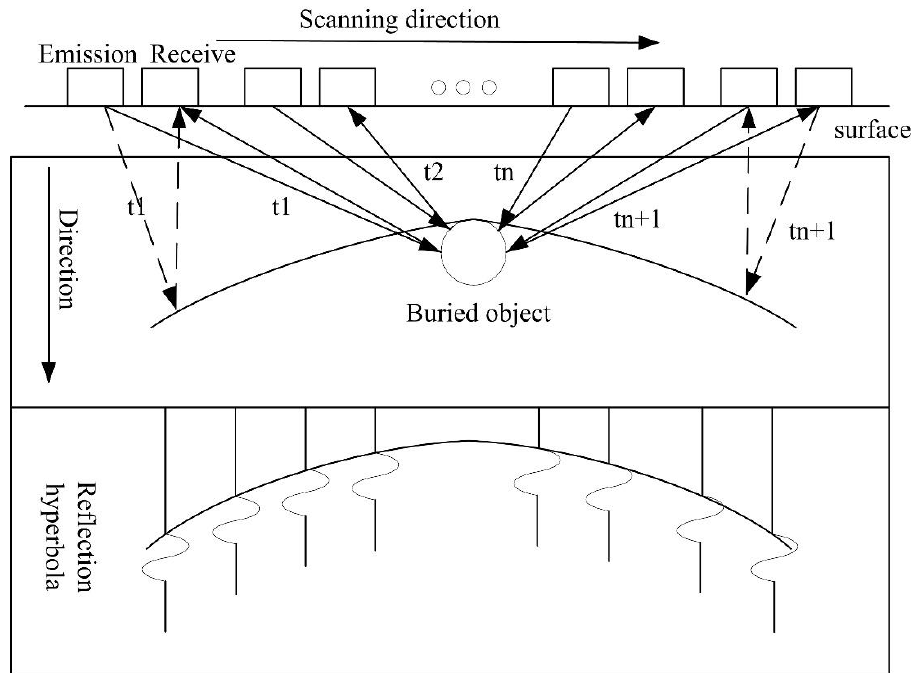
Figure 4. Schematic diagram of GPR reflection hyperbola